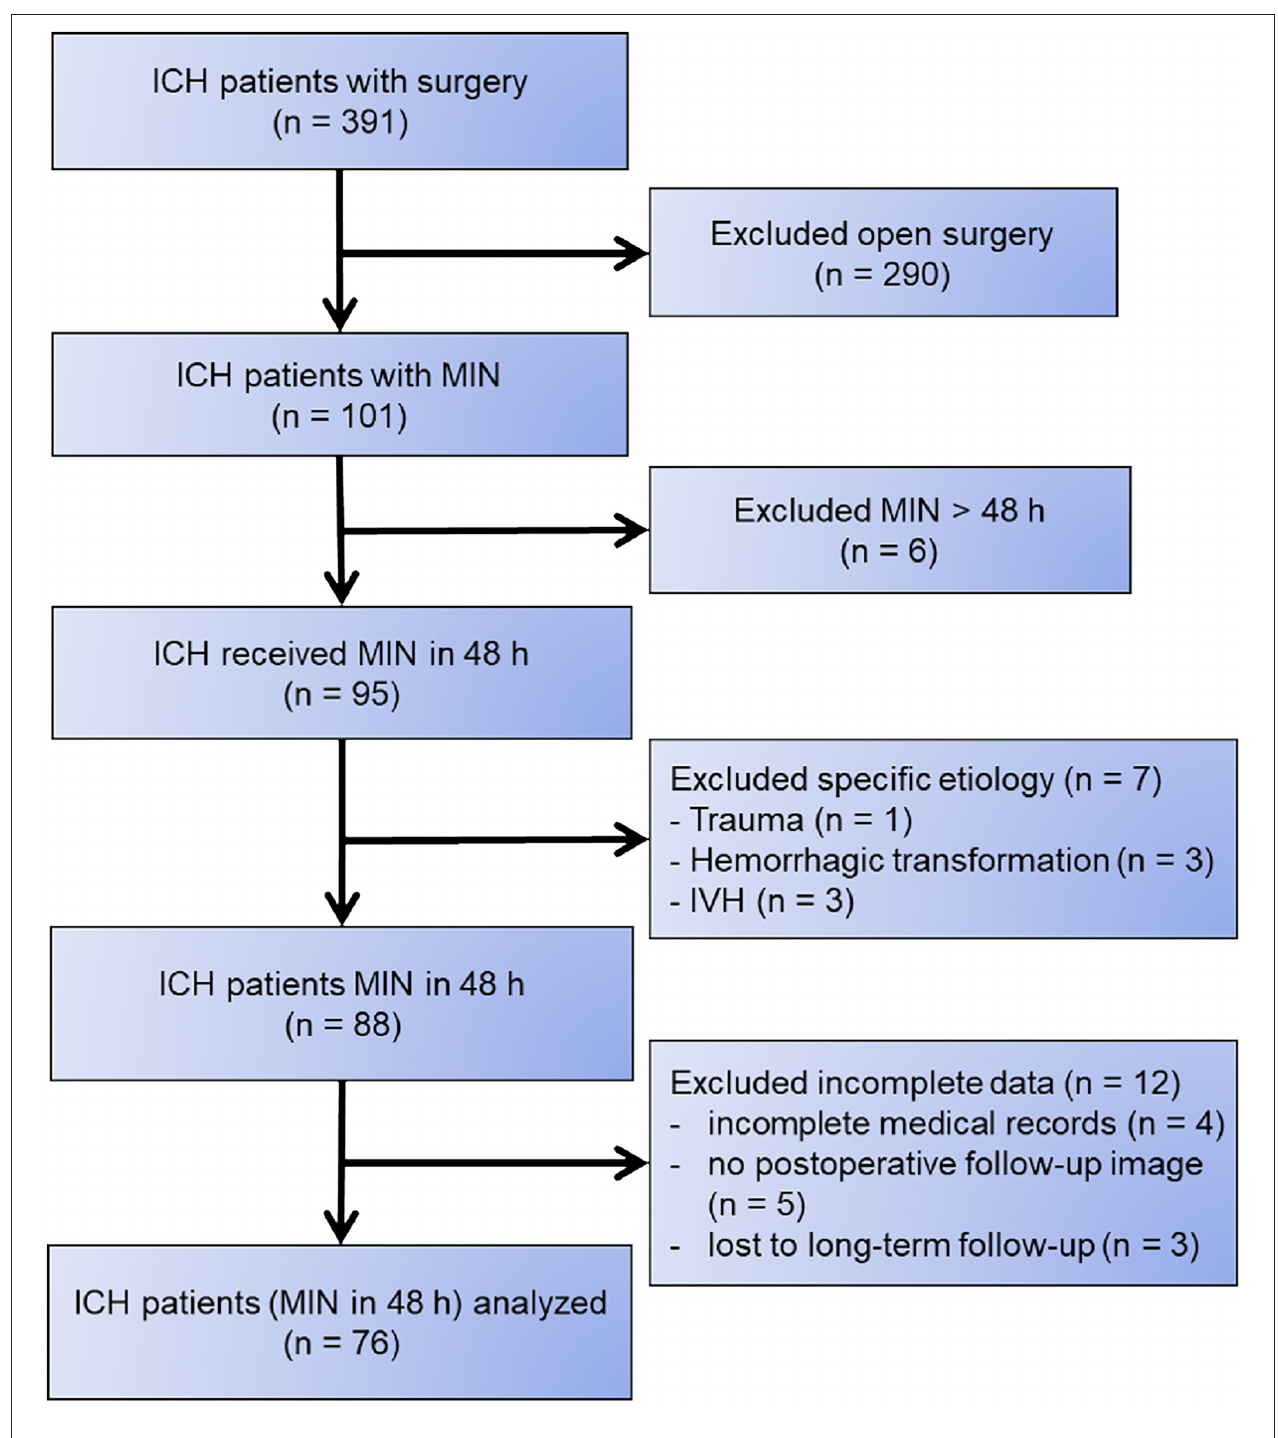
FIGURE 1 | Flowchart of patient